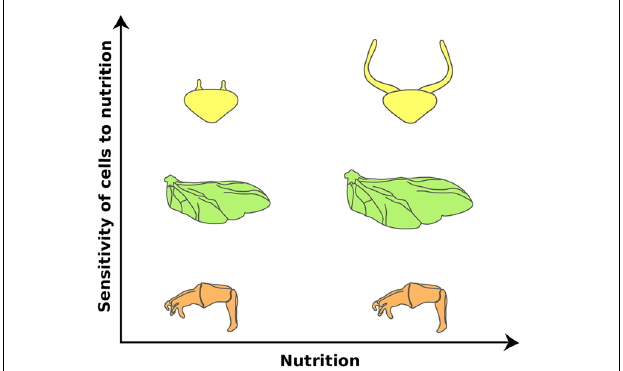
FIGURE 2 | Organs differ in their sensitivities to nutrition in the dung beetle, Onthophagus taurus . Nutrition affects the size of the wings (green) in proportion to the body. Other organs, such as the genital disc (orange), are less sensitive to changes in nutrition. This reduction of nutrition sensitivity is achieved by retaining high IIS/TOR signaling activity in low nutritional environments. In contrast, horn discs (yellow) show enhanced response to nutrition. Large males have disproportionately larger horns than small males. This hyperplastic response appears to be due to changes in organ sensitivity to nutrition via enhancing the IIS/TOR signaling activity. (Modified from Emlen et al.,